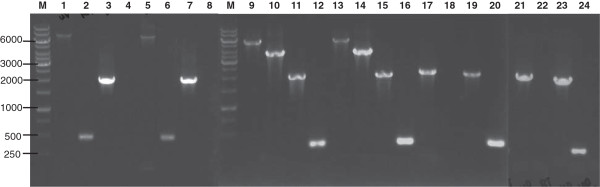
Verification of genomic deletions by PCR of genomic DNA. Amplimers using AdeGUp (NotI)F and AdeGDwn(SphI)R for DB (lane 1) and DBΔadeFGH (lane 3) DNA; amplimers using AdeG RTF and AdeG RTR for DB (lane 2) and DBΔadeFGH (lane 4) DNA; amplimers using AdeGUp (NotI)F and AdeGDwn(SphI)R for R2 (lane 5) and R2ΔadeFGH (lane 7) DNA; amplimers using AdeG RTF and AdeG RTR for R2 (lane 6) and R2ΔadeFGH (lane 8) DNA; amplimers using AdeJ(UP) PstI F and AdeJ(DWN) SphI R for R2 (lane 9), R2ΔadeIJK (lane 11), DB (lane 13) and DBΔadeIJK (lane 15); amplimers using AdeJ F and AdeK R for R2 (lane 10), R2ΔadeIJK (lane 12), DB (lane 14) and DBΔadeIJK (lane 16); DBΔadeFGHΔadeIJK DNA amplified using AdeGUp (NotI)F and AdeGDwn(SphI)R (lane 17), AdeG RTF and AdeG RTR (lane 18); AdeJ(UP) PstI F and AdeJ(DWN) SphI R (lane 19) and AdeJ F and AdeK R (lane 20); R2ΔadeFGHΔadeIJK DNA amplified with AdeGUp (NotI)F and AdeGDwn(SphI)R (lane 21), AdeG RTF and AdeG RTR (lane 22), AdeJ(UP) PstI F and AdeJ(DWN) SphI R (lane 23) and AdeJ F and AdeK R (lane 24); M, 1 kb DNA ladder (GeneRuler™).